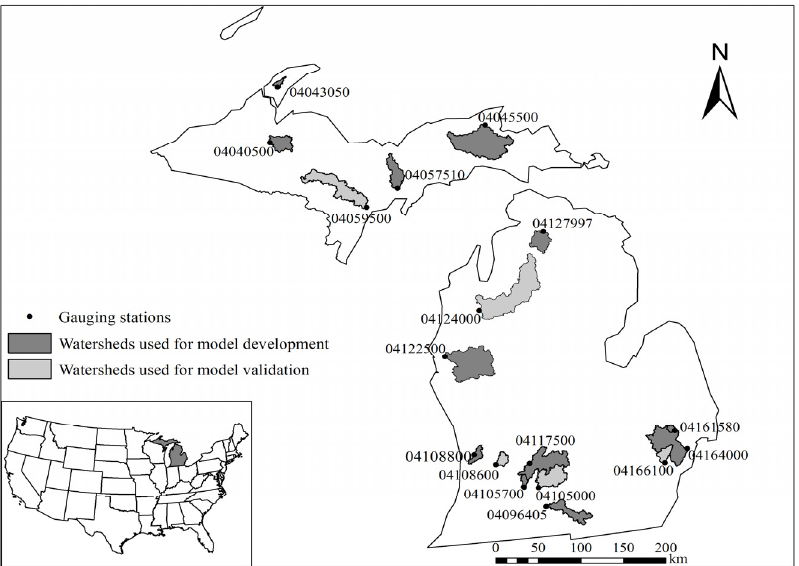
Figure 1. Gauging stations and delineated watersheds used for the study in